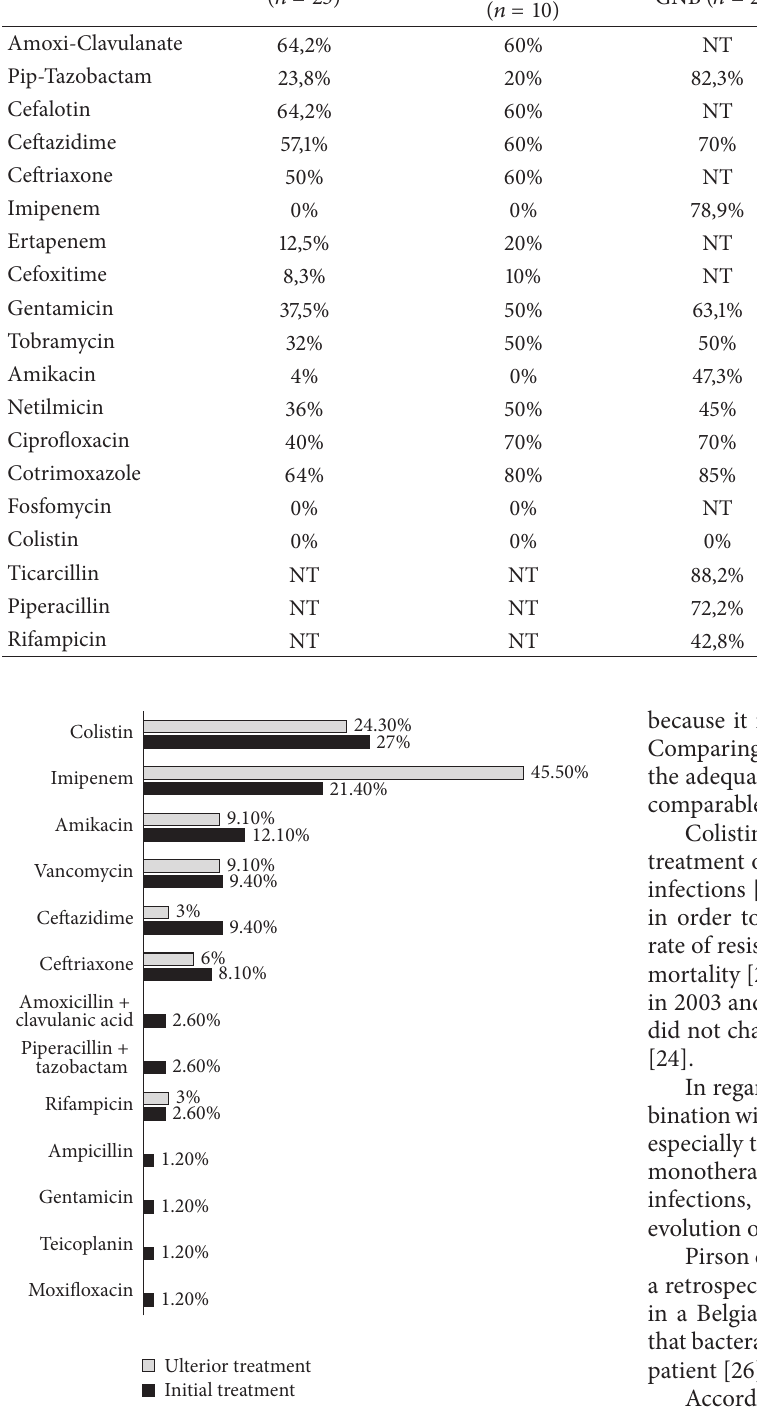
Figure 1: Molecules prescribed for initial and ulterior antibiotic